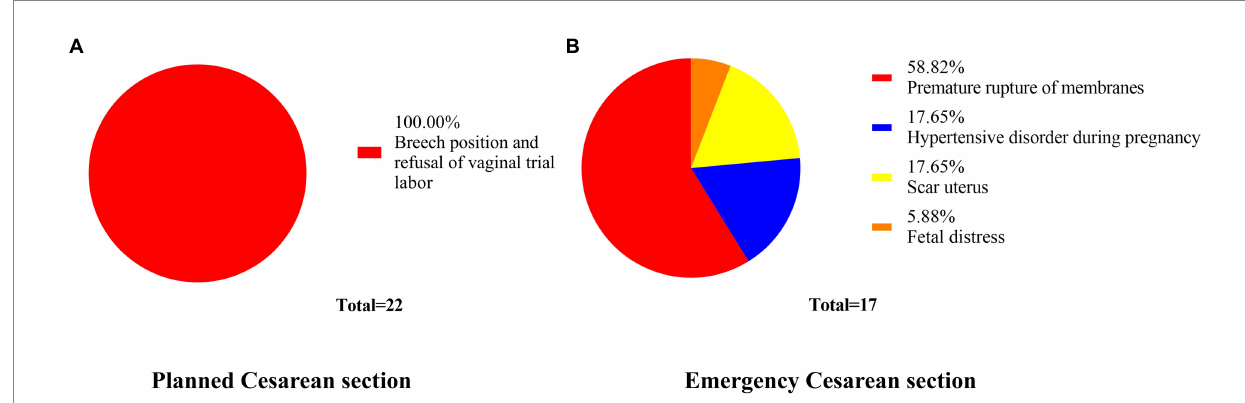
FIGURE 4 Cesarean section indication. All planned cesarean sections were indicated for breech presentation and refusing to undergo vaginal trial labor. Premature rupture of membranes accounts for the largest proportion of emergency caesarean sections. A and B indicate surgical indications for planned cesarean section versus emergency cesarean section, respectively